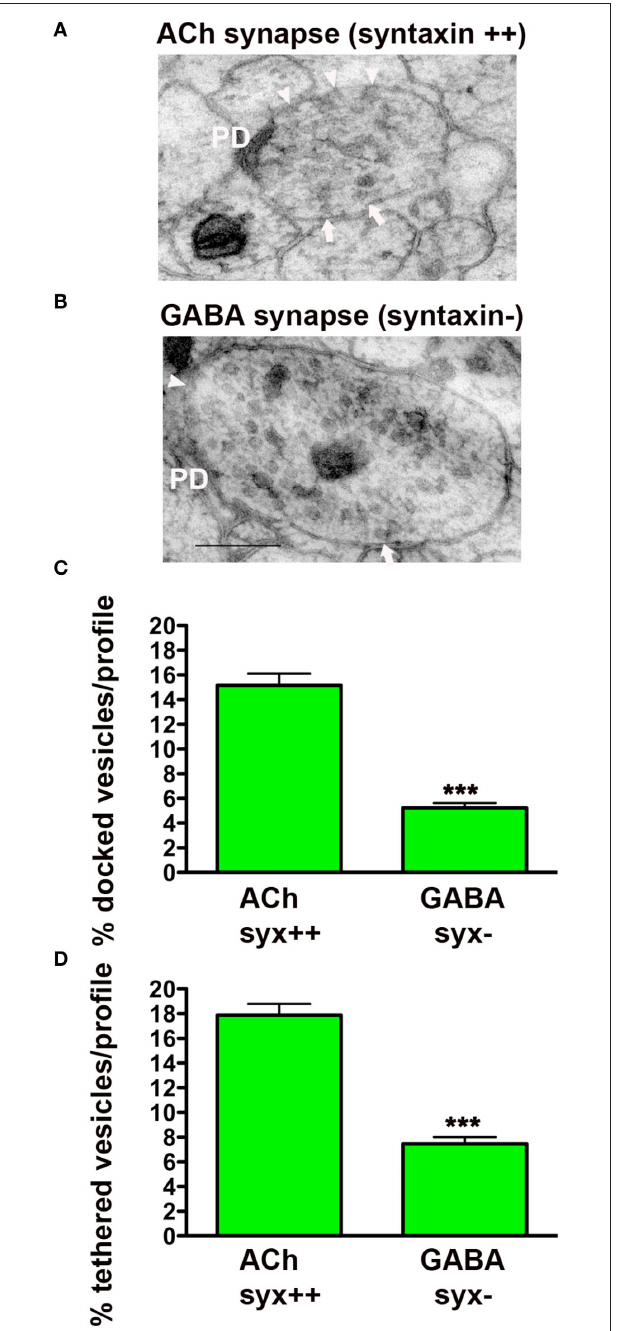
FigUre 3 | Synaptic vesicle tethering and docking are syntaxin-dependent. Representative electron micrographs of NMJ profiles of syntaxin mosaic animals (strain EG3278) which have cholinergic syntaxin-expressing synapses (A) and GABAergic syntaxin null synapses (B) . Arrowheads indicate plasma membrane docked synaptic vesicles, arrows indicate tethered synaptic vesicles ( < 25 nm of the plasma membrane), PD presynaptic density, scale bar 200 nm. Average docked (C) and tethered (D) synaptic vesicles expressed as a percentage of total vesicles per synaptic profile for cholinergic syntaxin-expressing synapses (syx ++ , n = 24 synaptic profiles, vesicle density 25 ± 1.0) and GABAergic syntaxin null synapses (syx − , n = 35 synaptic profiles, vesicle density 37.1 ± 1.6). *** p < 0.001 GABAergic synapses relative to cholinergic synapses.